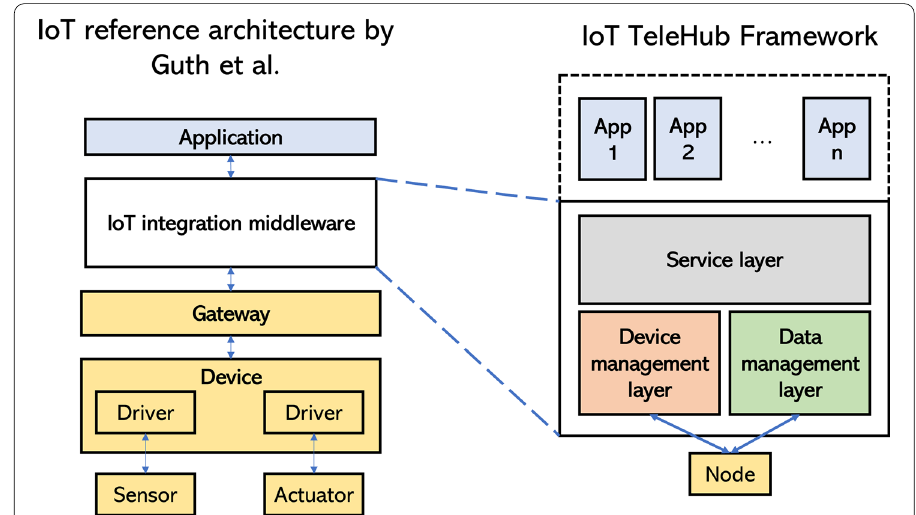
Fig. 8 Mapping of the proposed framework and the IoT reference architecture in [49]